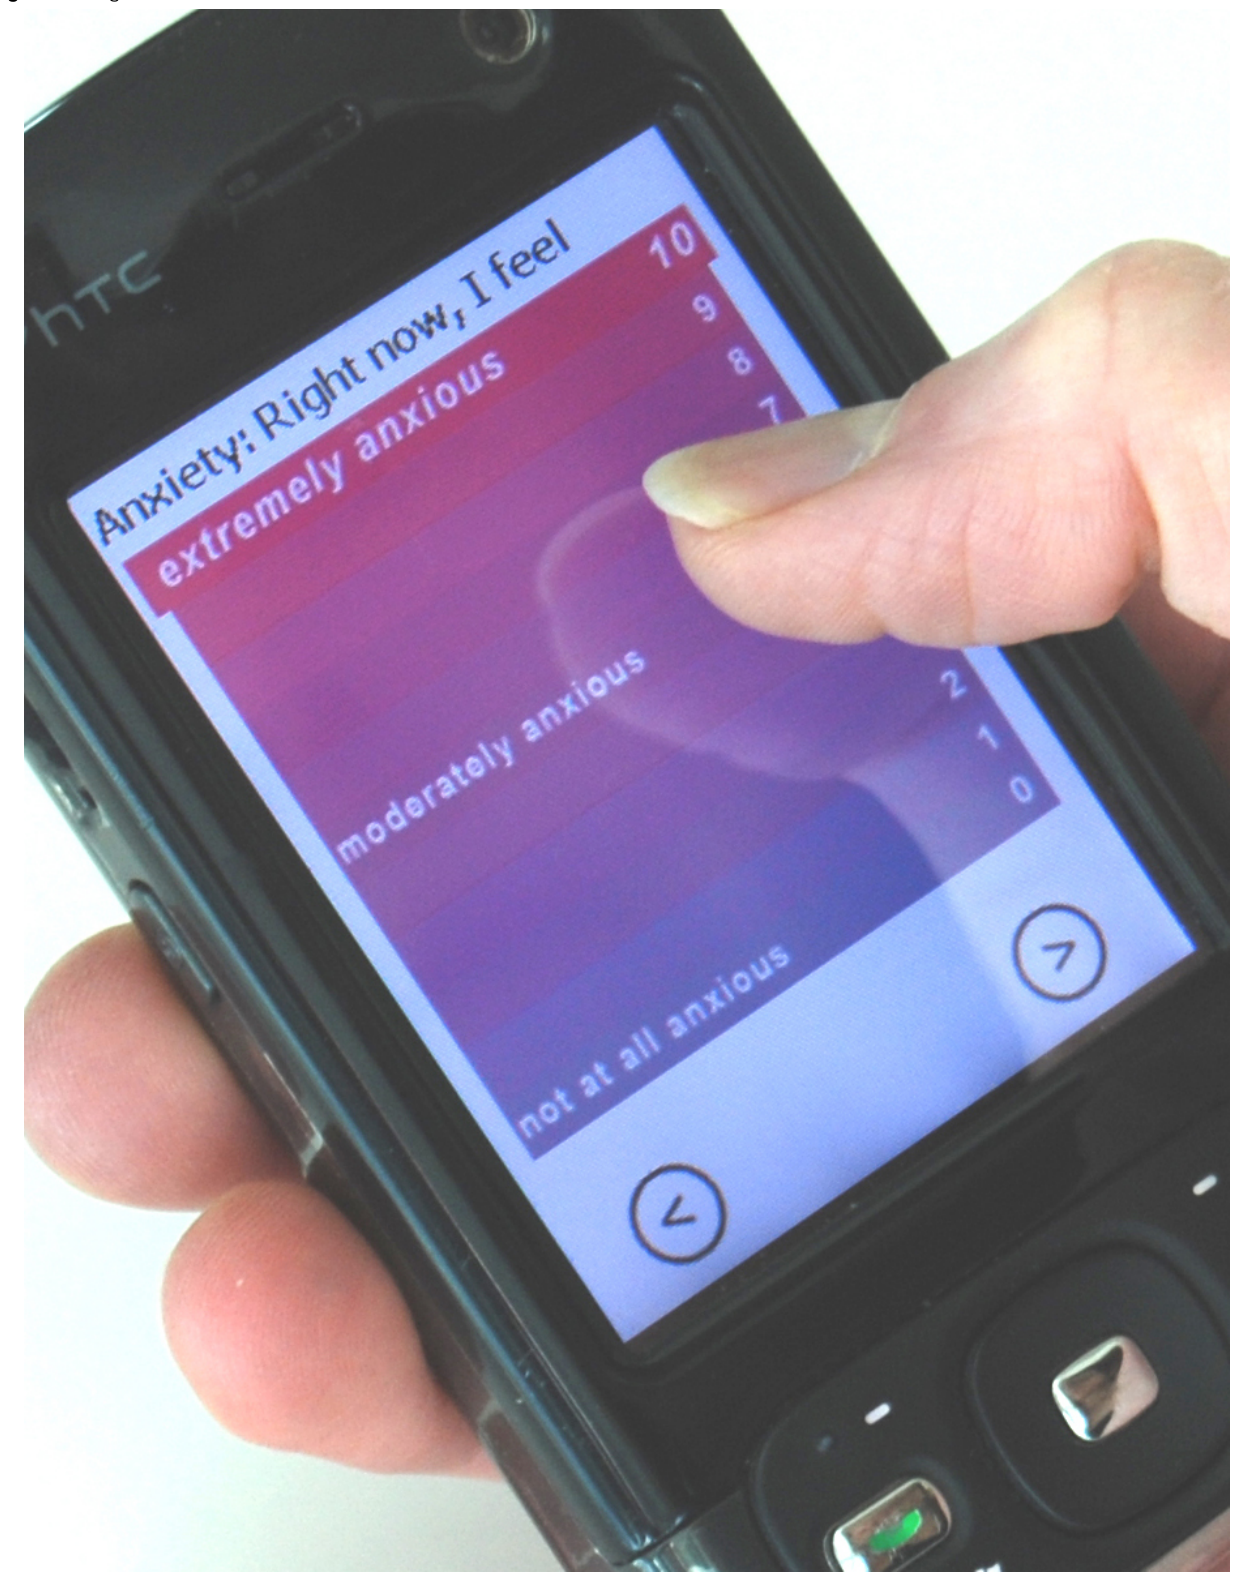
Single-dimension mood scales for anger, anxiety, happiness, and sadness were used in addition to the Mood Map. These measures of specific emotions complemented the general expression of emotional experience captured by the Mood Map. These mood scales, adapted from a rating scale by Brown [17],